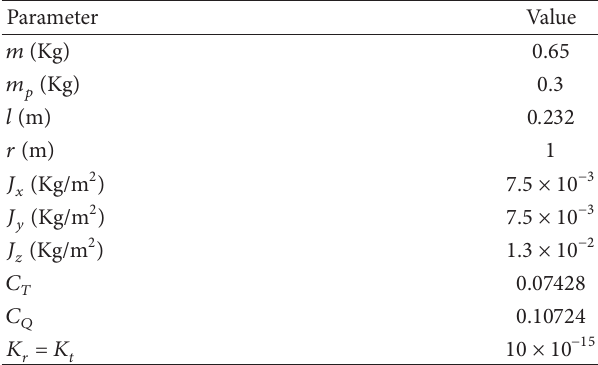
Table 2: Physical parameters of the